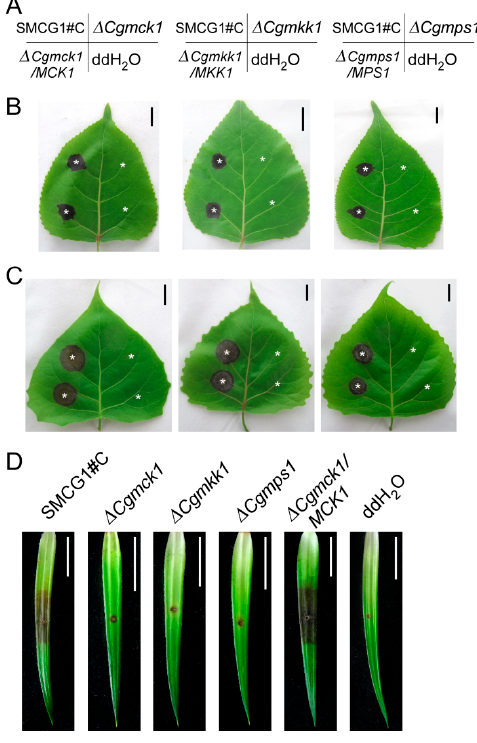
Figure 5. CgMck1 required for pathogenicity to host plant. ( A ) The conidial suspension inoculation position of the wild type SMCG1#C, ∆ Cgmck1 , ∆ Cgmkk1 , ∆ Cgmps1 and the complemented strains